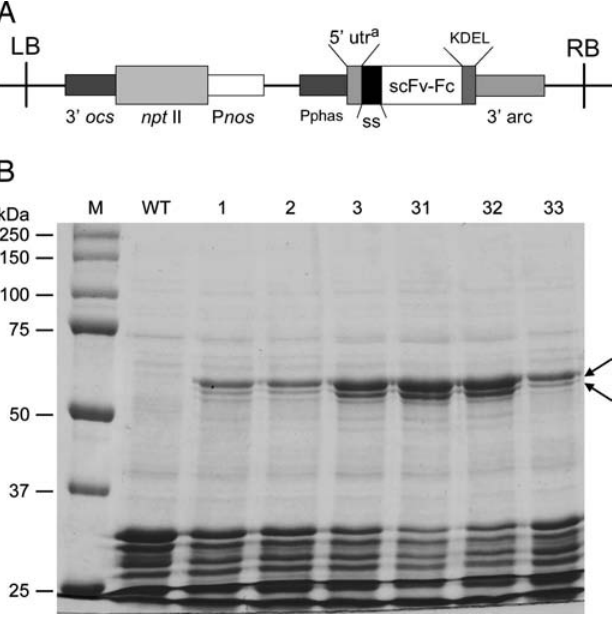
Fig. 1. Expression of scFv-Fc in transgenic Arabidopsis plants. ( A ) Schematic diagram of the T-DNA region in the binary vector pPhas. P nos , nopaline synthase gene promoter; npt II, coding sequence of the neomycin phospho- transferase II gene; 3 (cid:2) ocs , 3 (cid:2) end of the octopine synthase gene; Pphas, (cid:2) -phaseolingenepromoter( (cid:3) 1 to (cid:3) 1,470;GenBankaccessionno.J01263);5 (cid:2) utr a , 5 (cid:2) UTR of arc5-I gene (13 bp; part of GenBank accession no. Z5020) (42); 3 (cid:2) arc,3 (cid:2) -flankingregulatorysequencesofthe arc5-I genomicclone(3,900bp; part of GenBank accession no. Z50202) (42); ss, signal peptide of the Arabi- dopsis 2S2 seed storage protein gene (43); scFv-Fc, scFv-Fc coding sequence; KDEL, ER retention signal (16); RB and LB, T-DNA right and left border, respectively. ( B ) Coomassie-stained, reducing ( (cid:4) DTT) SDS/PAGE gel on which 40 (cid:3) g was loaded of total seed protein extracts from wild-type (WT), and transgenic MBP10-producing Arabidopsis lines 1, 2, 3, 31, 32, and 33. The arrows indicate the doublet of scFv-Fc monomer bands. M, Precision Plus Protein Dual Color Standards (Bio-Rad).